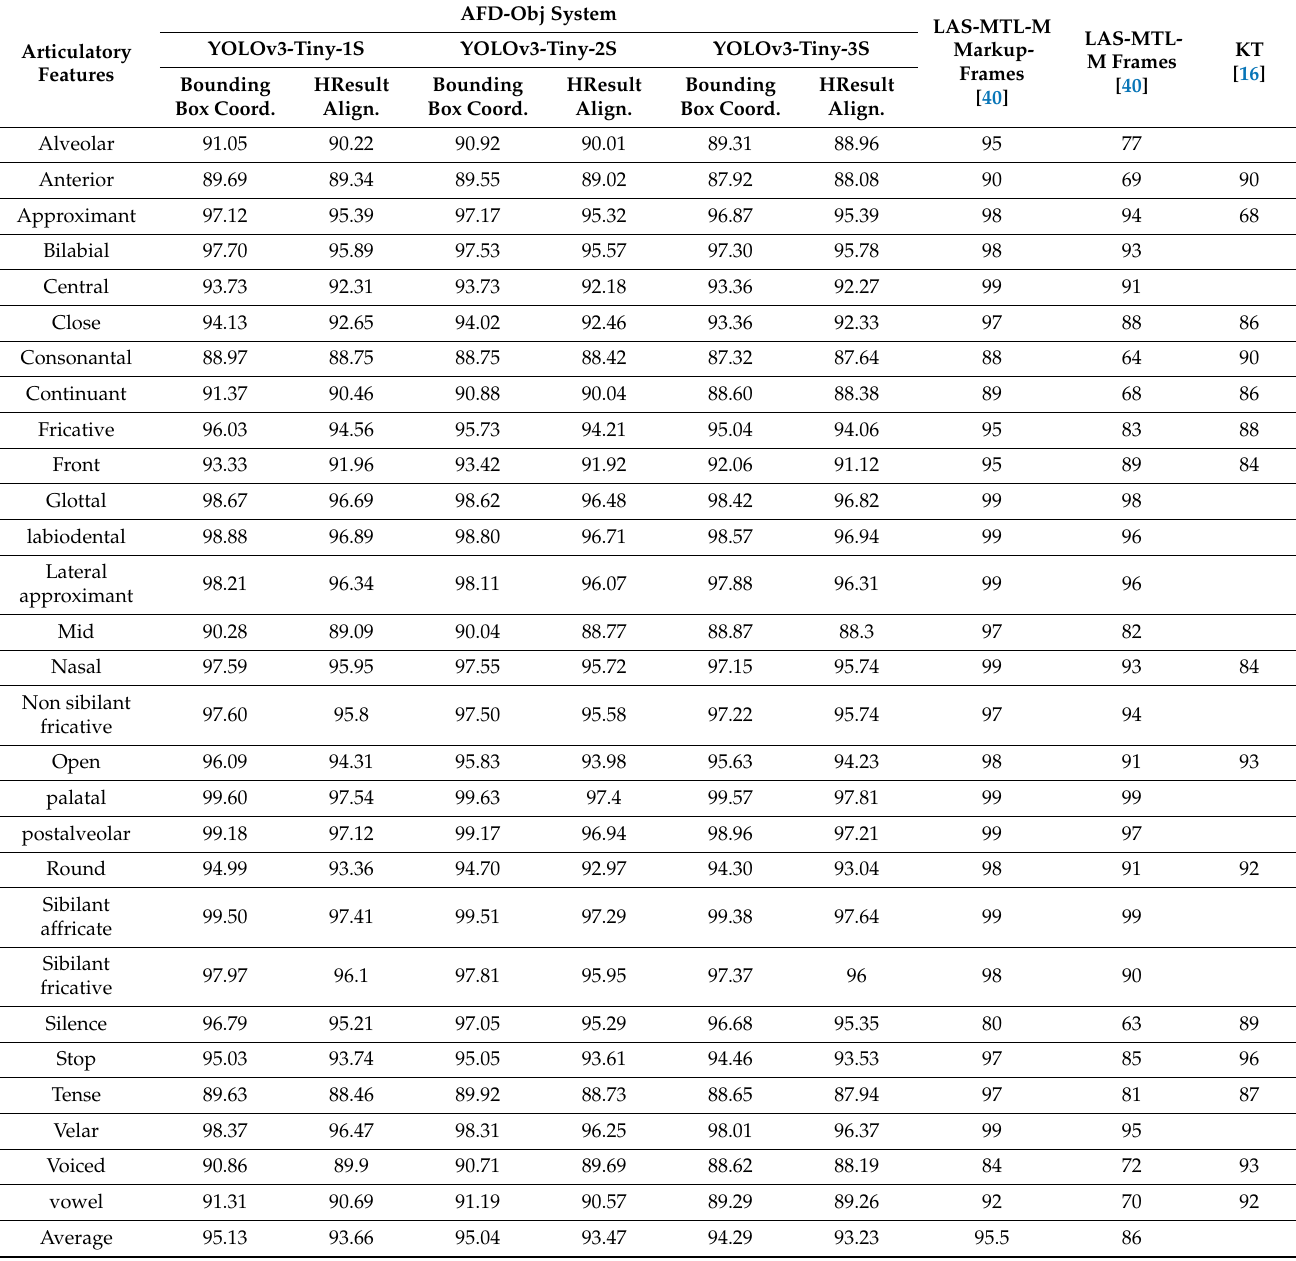
Table 6. Detection accuracy of all 28 English AFs using the proposed system AFD-Obj and state-of-the-art